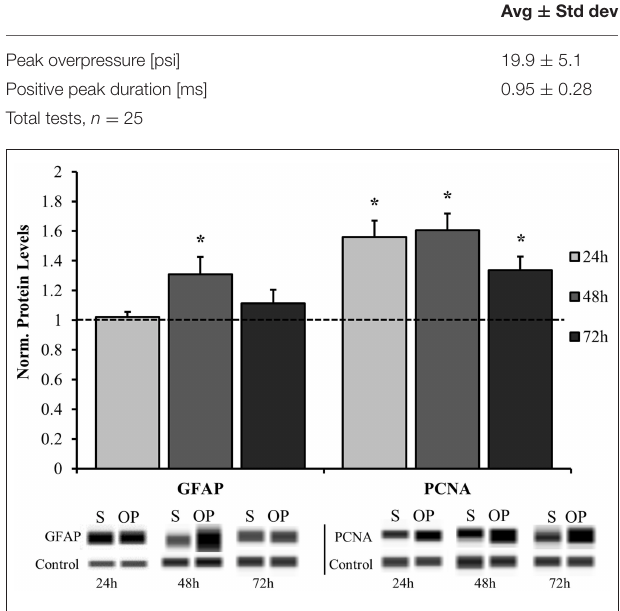
FIGURE 3 | Time course analysis for normalized protein expression of classical reactivity markers. GFAP was significantly elevated in the overpressure group at 48h while PCNA was increased at 24, 48, and 72h compared to their respective shams. * p < 0.05, Data are represented as mean ± SEM, n = 8–13/group.